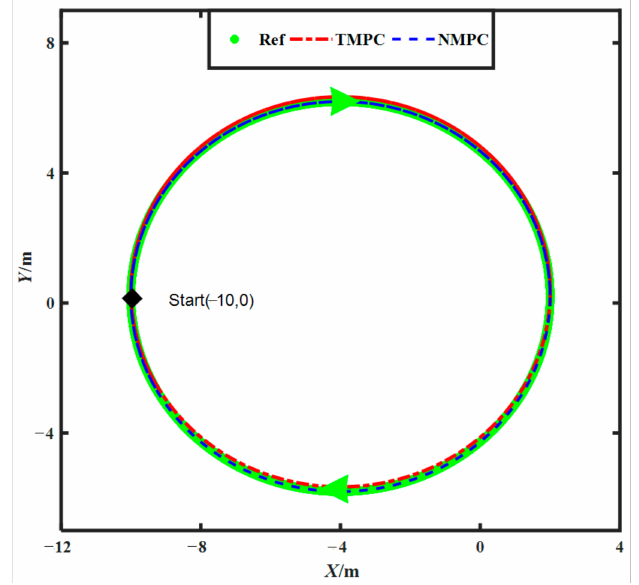
Figure 6. The simulation tracking results under the